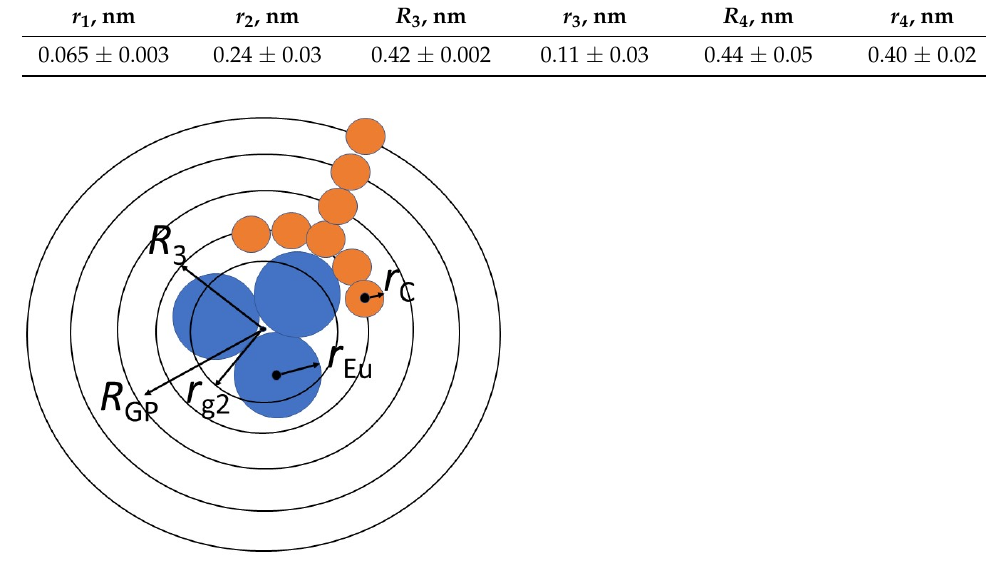
Figure 5. Spherical model of globule with central Eu-cluster and carbon shell (4 layers): r C and r Eu are atomic radii for carbon and Eu; r g2 and R GP are gyration radii for Eu-cluster and globule; R 3 denotes a location of the carbon layer contacting with the Eu-cluster.